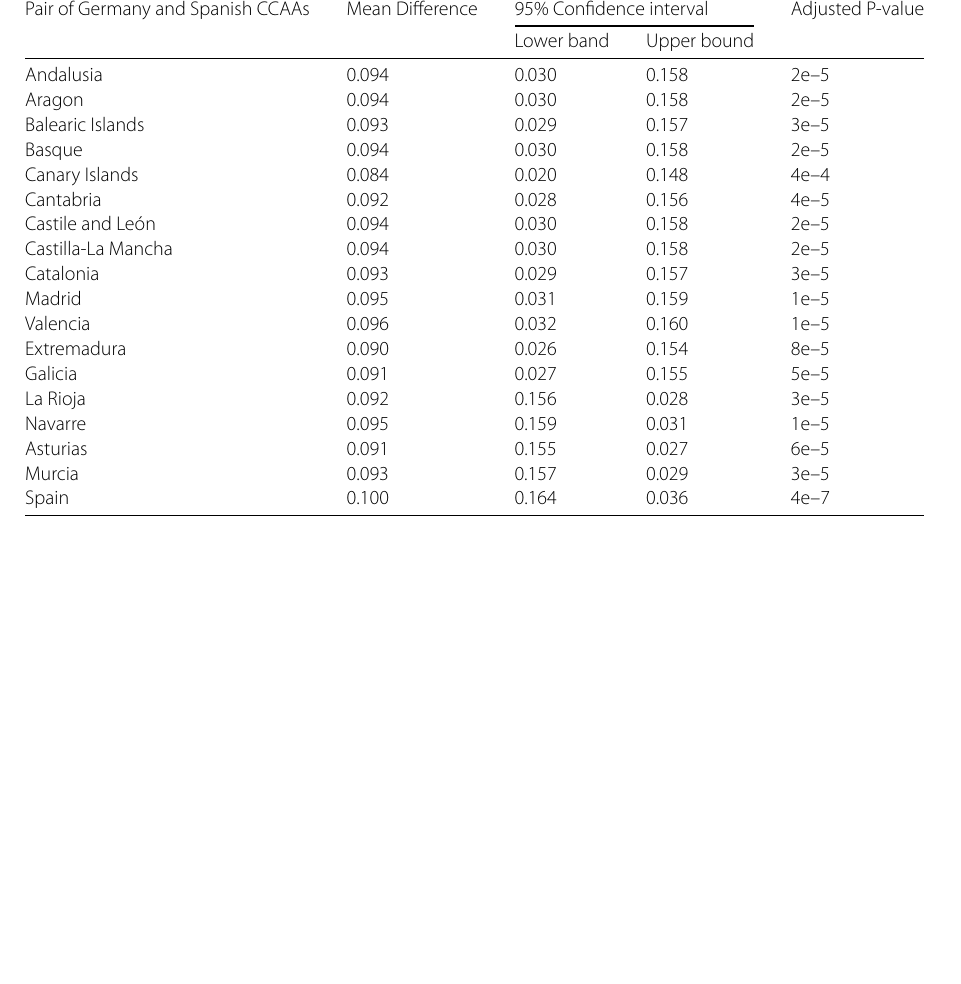
Table 14 HSD Tukey test results filtered by for the pair of CCAAs-countires which include Italy Pair of Italy and Spanish CCAAs